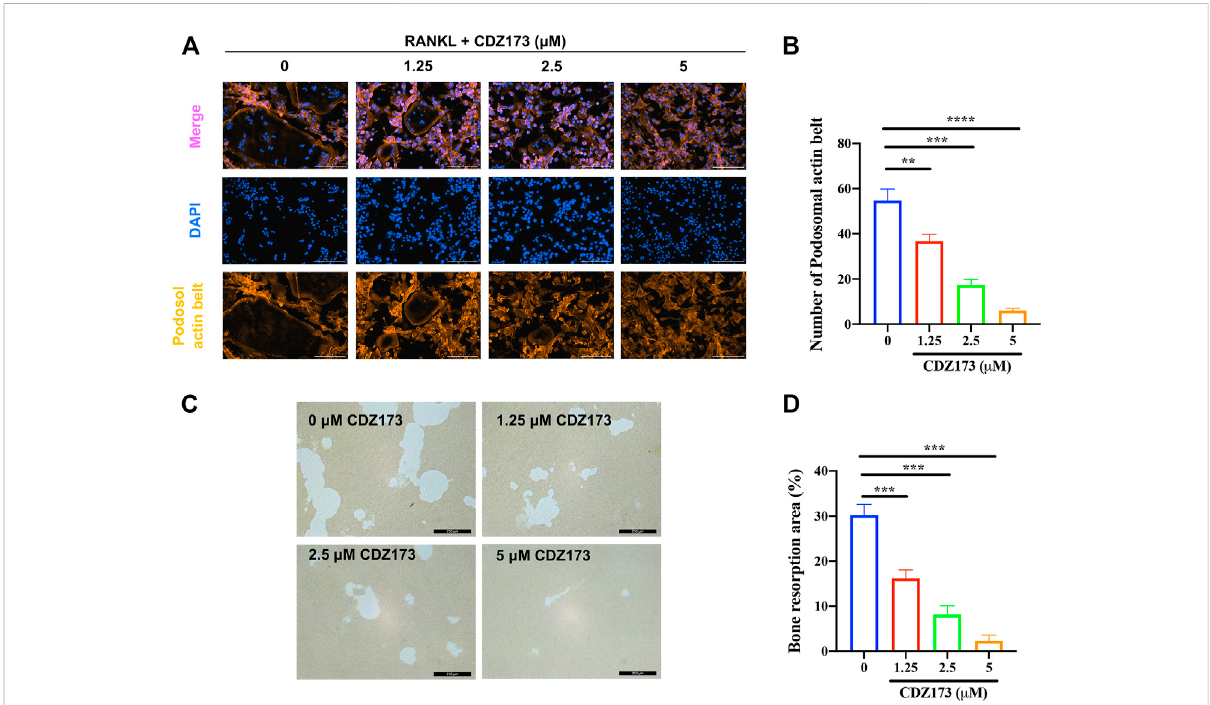
FIGURE 4 CDZ173 inhibitedboneresorptionandosteoclast fusion invitro (A) BMMs werestimulatedfor5dayswith M-CSF(30 ng/ml)and RANKL(30 ng/ ml) intheabsenceor presence ofindicatedconcentrationsofCDZ173,then fi xedand immunostained forpodosomealactin belt.The representative image of the podosomal actin belt (Orange) in osteoclasts was captured by an immuno fl uorescence microscope. The nuclei (blue) were counterstained with DAPI (scale bar = 200 µM). (B) The number of podosomal actin belts in each group was quanti fi ed. (C) Mature OC were placed in hydroxyapatite-coated plates and treated for 24 h with 5 µM CDZ173. Attached cells were removed and micrographs of bone resorption pits were taken under a light microscope (scale bar = 250 µM). (D) The proportion of bone resorption area in total bone resorption area